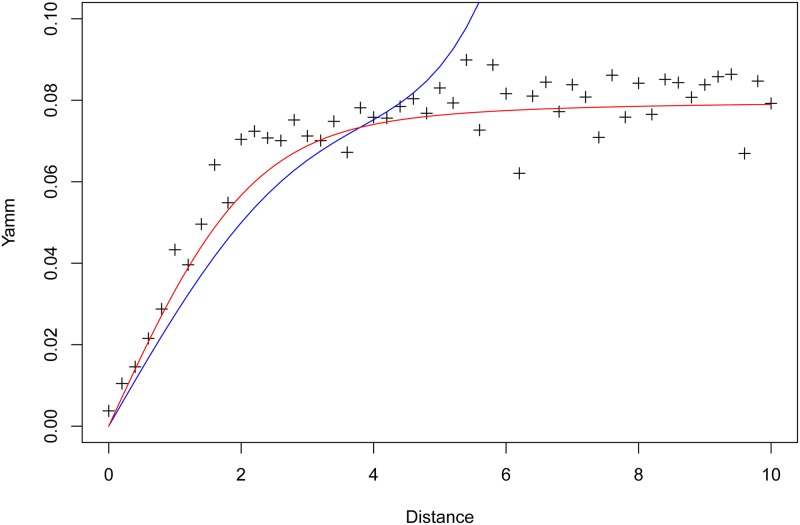
Yamm computed on simulated setup, increasing the distance between two bivariate normals.Crosses: numerically computed values; Solid blue line: approximation computed for general ν1 and ν2; Solid red line: approximation computed when ν1 = (0, 0)T and ν2 = (0, d)T.